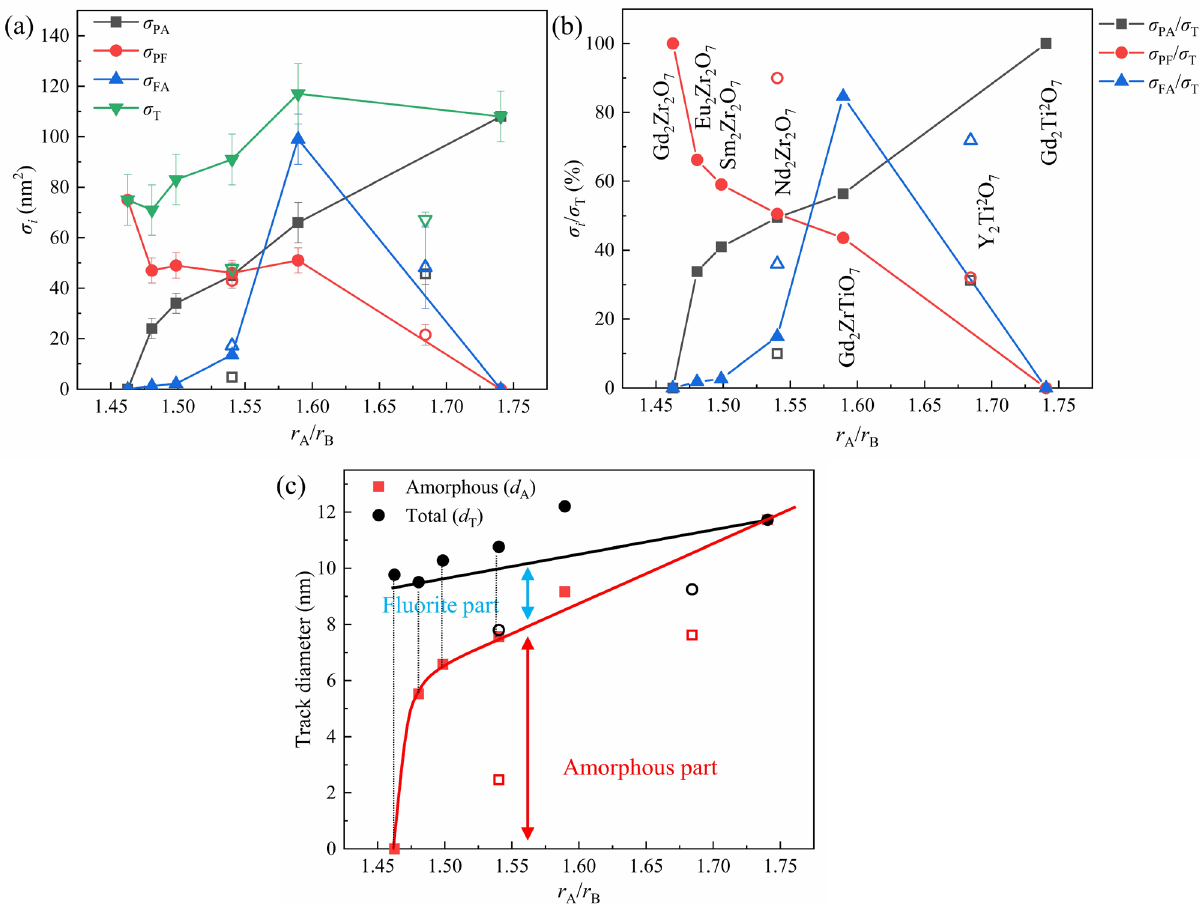
Figure 12. Variation in of ( a ) cross-section σ i , ( b ) σ i / σ T , ( c ) the total track diameter ( d T ), and the amorphous track core diameter ( d A ) as a function of the cation radius ratio for pyrochlore ceramics. The solid marks are Gd 2 Ti 2 O 7 , Gd 2 TiZrO 7 , Gd 2 Zr 2 O 7 , Sm 2 Zr 2 O 7 , Eu 2 Zr 2 O 7 , and Nd 2 Zr 2 O 7 irradiated with 119 MeV U ions [61,62,142], while the hollow marks represent Nd 2 Zr 2 O 7 and Y 2 Ti 2 O 7 irradiated with 93 MeV Xe ions from Ref. [62,188]. The lines are guides for the eye.